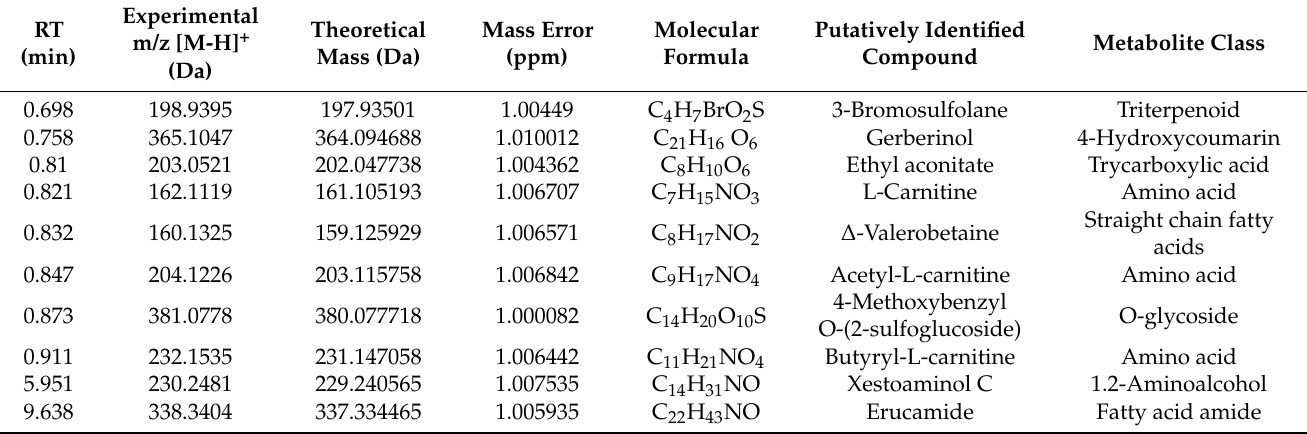
Table 1. Compounds identified in delactosed milk whey from Italian Mediterranean dairy buffaloes ( Bubalus bubalis ) by HPLC-MS